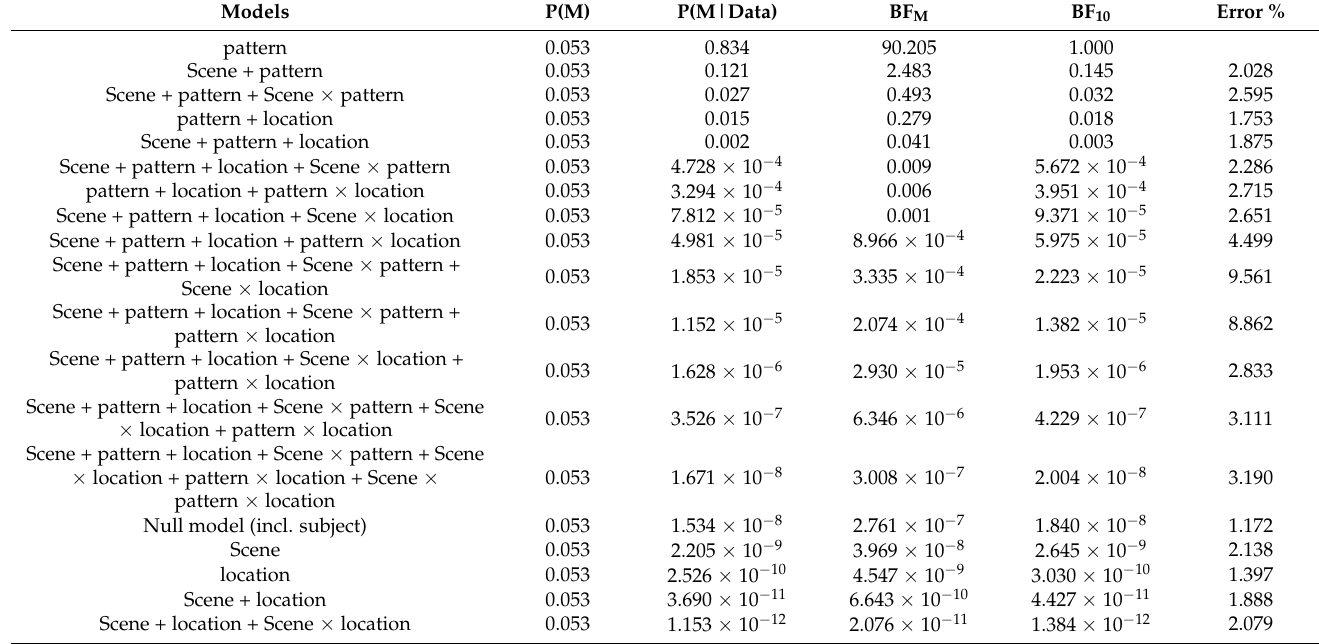
Table 2. Model comparison using Bayesian rmANOVA in the early component.